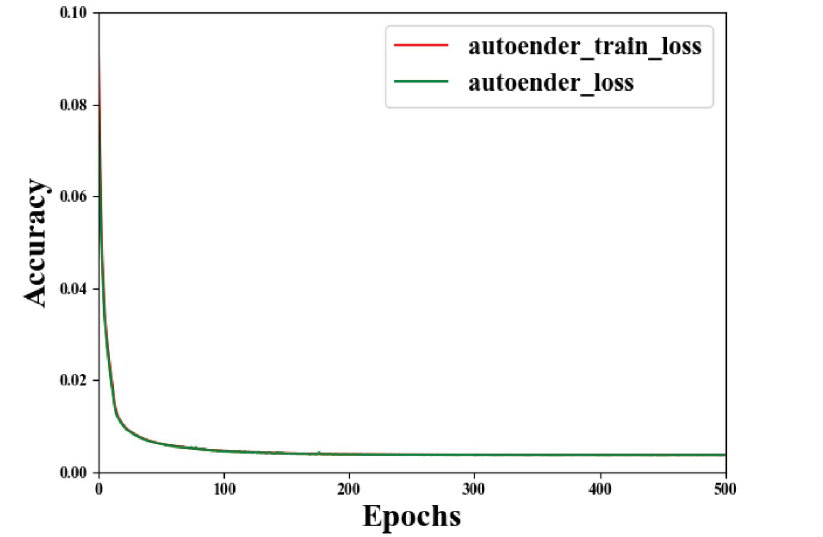
Fig 7. Loss curve of autoencoder network.